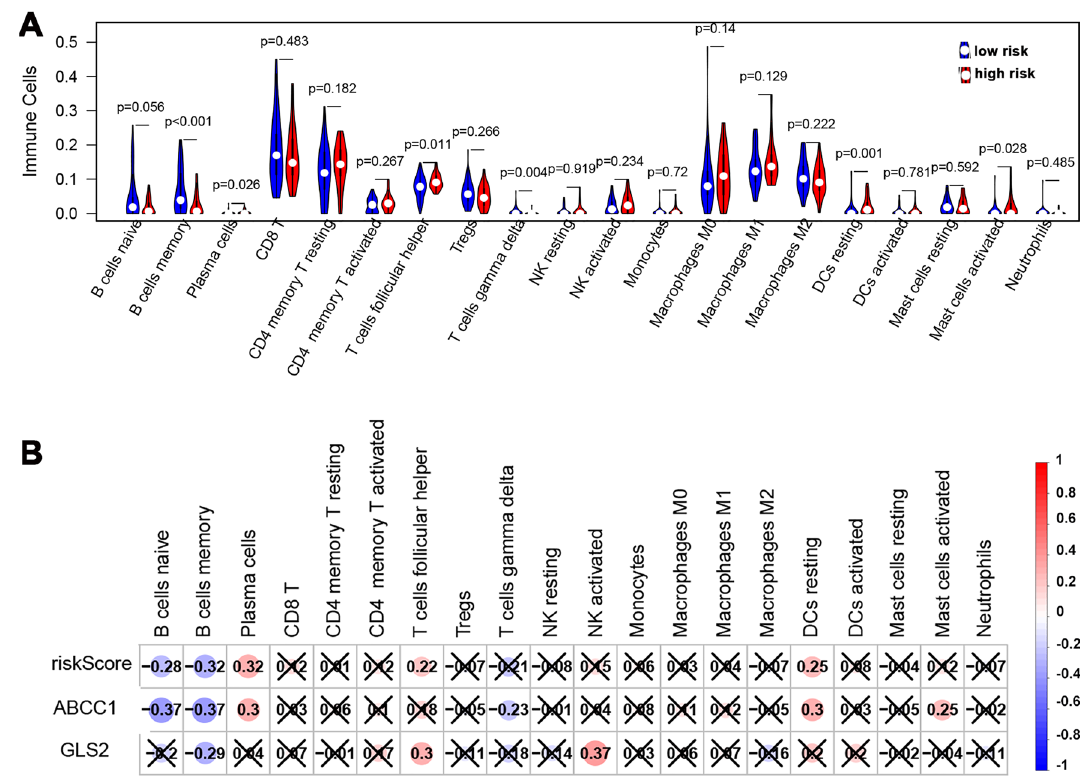
Figure 8. Immune infiltration in different risk-status. ( A ) The immune cell infiltration in the high/low-risk patients. ( B ) The risk score, FRGs ABCC1 and GLS2 were linked to infiltration abundances in different immune cells.